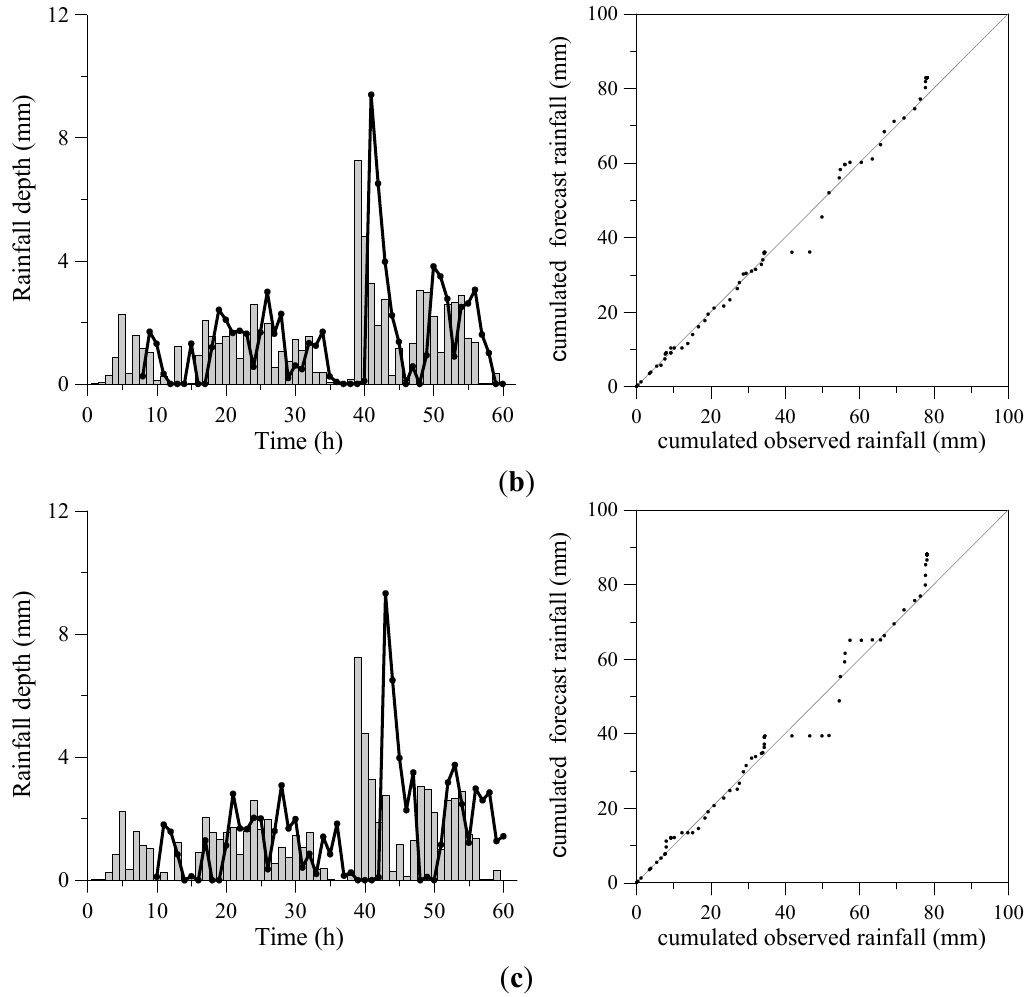
Figure 4. Grey model for rainfall forecasting in Goodwin Creek watershed: ( a ) 1-h